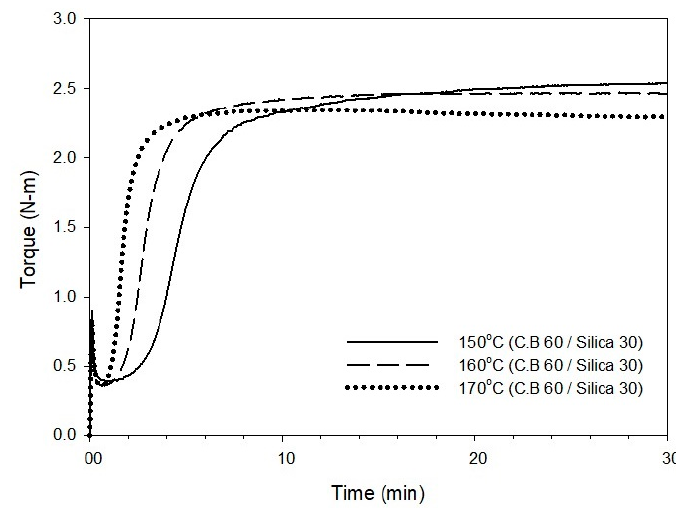
Figure 3. Cure curve of the T-3 compound at different cure temperatures of 150, 160, and 170 °C. Table 3. Cure characteristics of the T-3 compound at different cure temperatures.